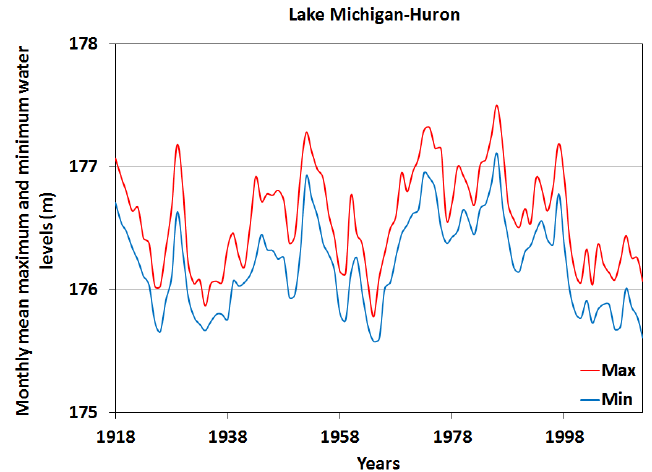
Figure 3. Temporal variability of monthly mean maximum water levels in Lake Michigan-Huron (1918–2012). No shift in the means.